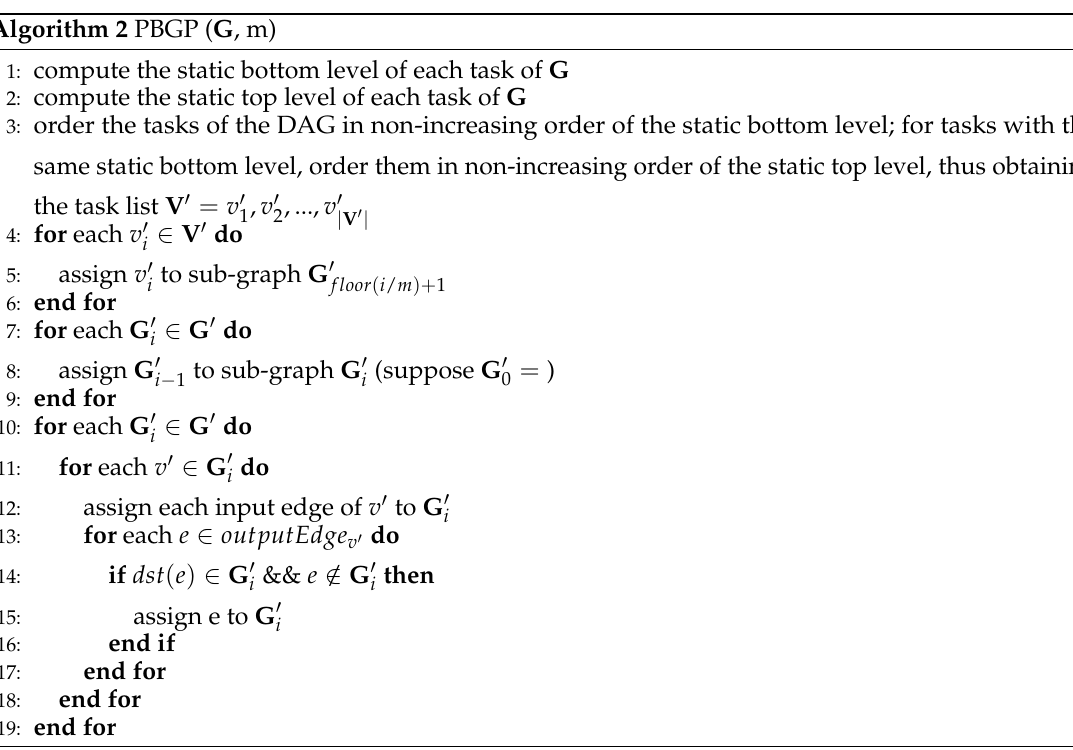
Algorithm 2 PBGP ( G , m)